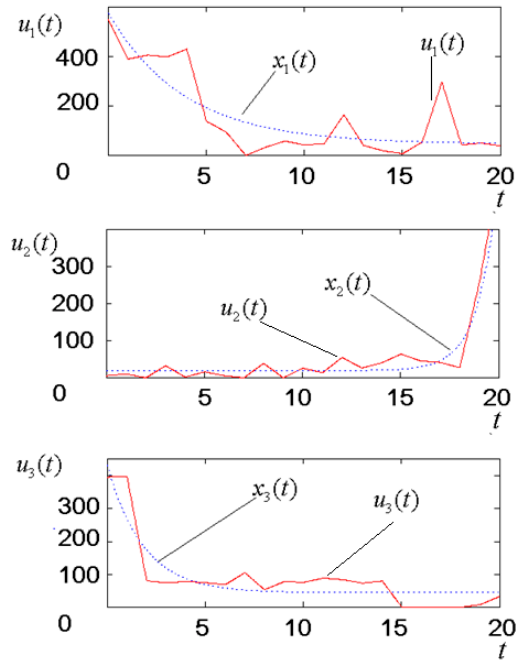
8 of 13 Figure 1. Graphs of the experimental probability density of traffic intensity at fixed times t 1 , t 2 , t 3 . To obtain an analytical expression describing the dynamics of the observed object within the framework of this work, it is proposed to divide the entire observation interval into local sections and solve the optimization problem separately for each section. In small areas, the instantaneous values of traffic intensity are well approximated by an exponential curve. In Figure 2,